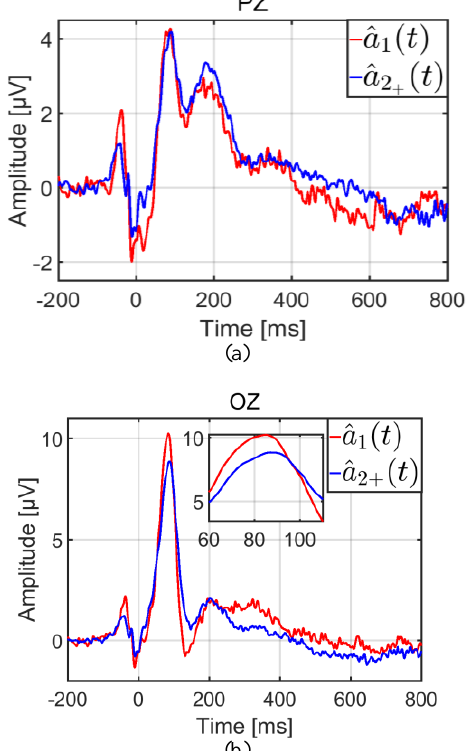
Figure 4 Grand average of the EFRP at the first fixation 𝑎̂ 1 (𝑡) (red line) and at the second and subsequent fixations 𝑎̂ 2 (blue line), estimated by the three-class GLM (a) on PZ and (b) OZ electrodes